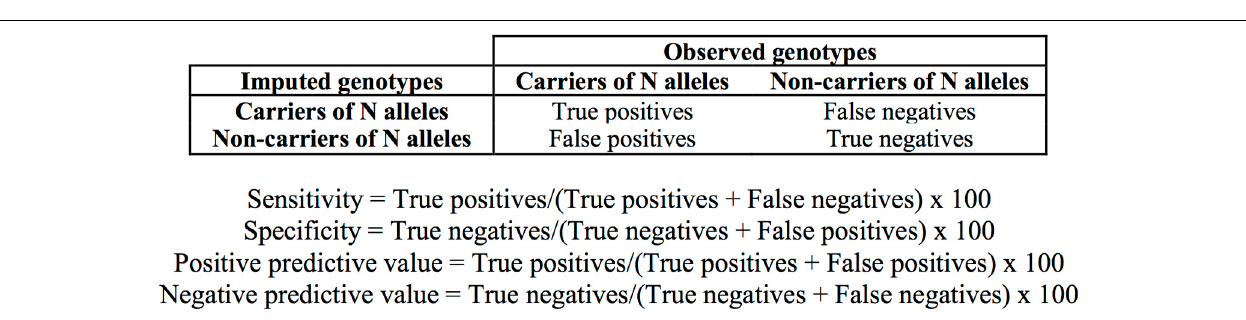
FIGURE 2 | Definition of true and false positive and negative values and formulae used for the determination of the sensitivity, specificity, and predictive values of the imputation.